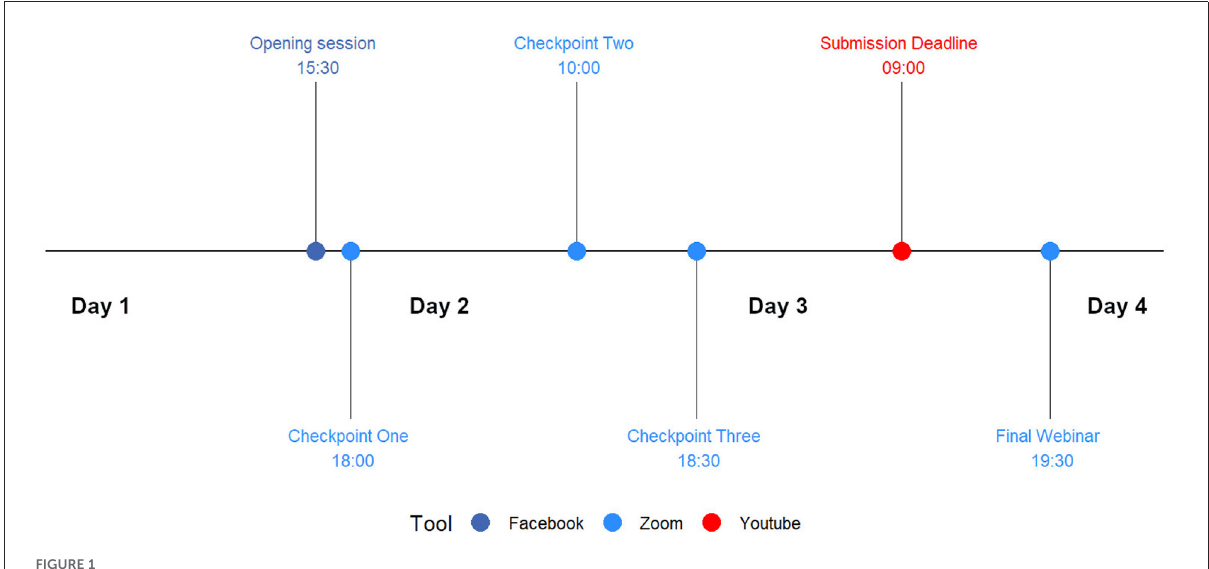
FIGURE1 Timeline of milestones during the hackathon.